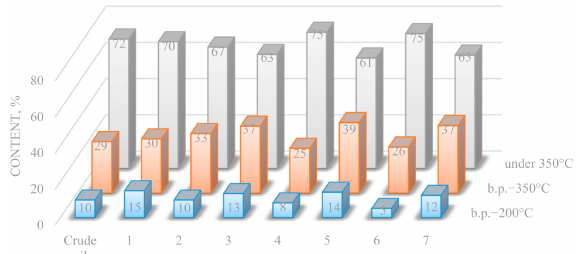
Figure 3. Yield of low-boiling fractions in the original and hydrothermally converted oil in the presence of rock-forming and catalytic compounds.